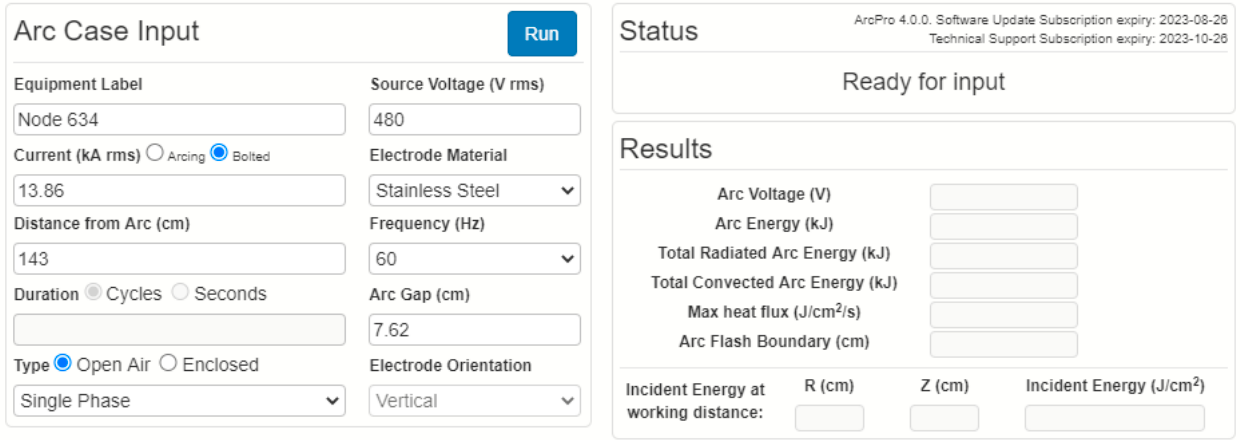
Figure 7. Data input screen for ArcPro simulation—Case study 2. Table 4. Relation of input data for ArcPro simulation—Case study 2.